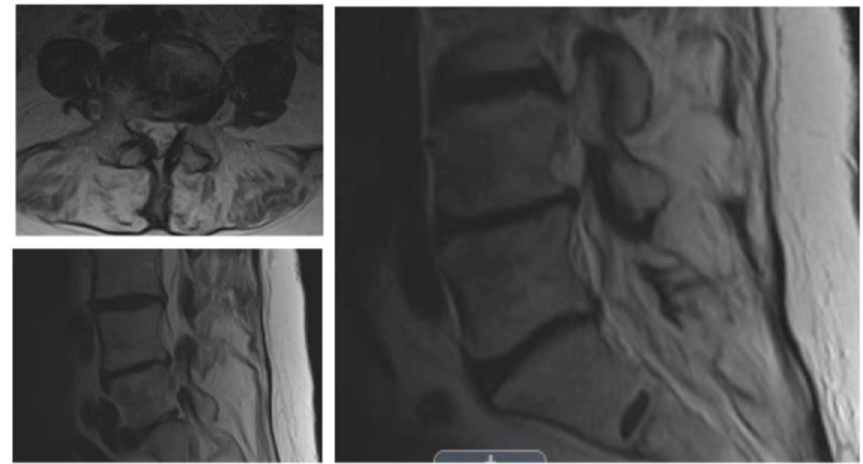
Figure 1. The patient vignette given to responding surgeons described a 66-year-old female with a 6-month history of progressive leg and back pain consistent with neurogenic claudication unrespon- sive to conservative treatments. The patient consistently rated her symptoms > 50/100 on the visual analog scale (VAS) for back pain, and her associated disability > 40% with the Oswestry Disability Index (ODI).